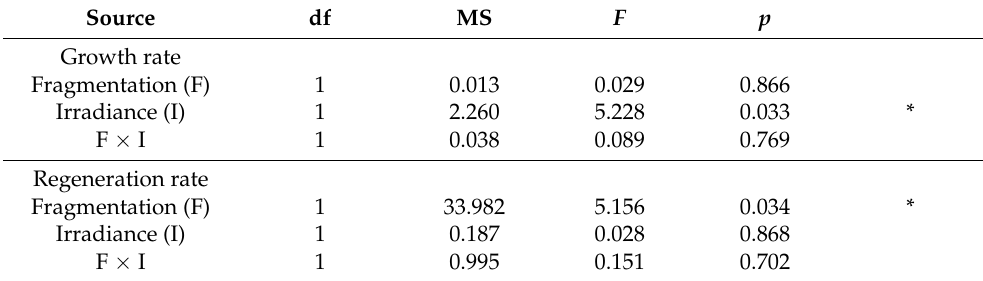
Table 3. Results of two-way ANOVA on the effects of fragmentation and irradiance on the relative growth and regeneration rates of Sargassum fusiforme